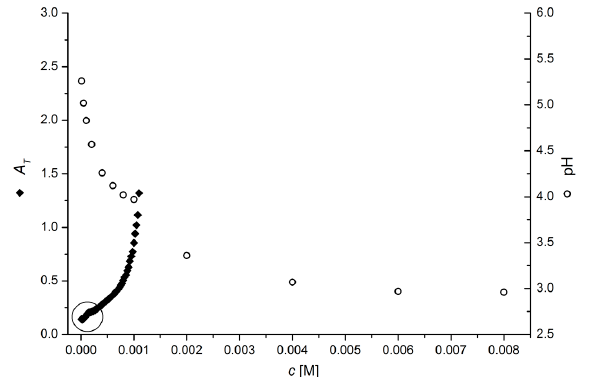
Figure 5. A T of main pyrene peaks at 336 and 320 nm vs. concentration ( c ) profile for compound 7 in aqueous medium at 25 °C in whole measured concentration range ( ◆ ); circle indicates concentration range where cmc was determined; pH values vs. concentration ( c ) profile at 25 °C ( ○ ).